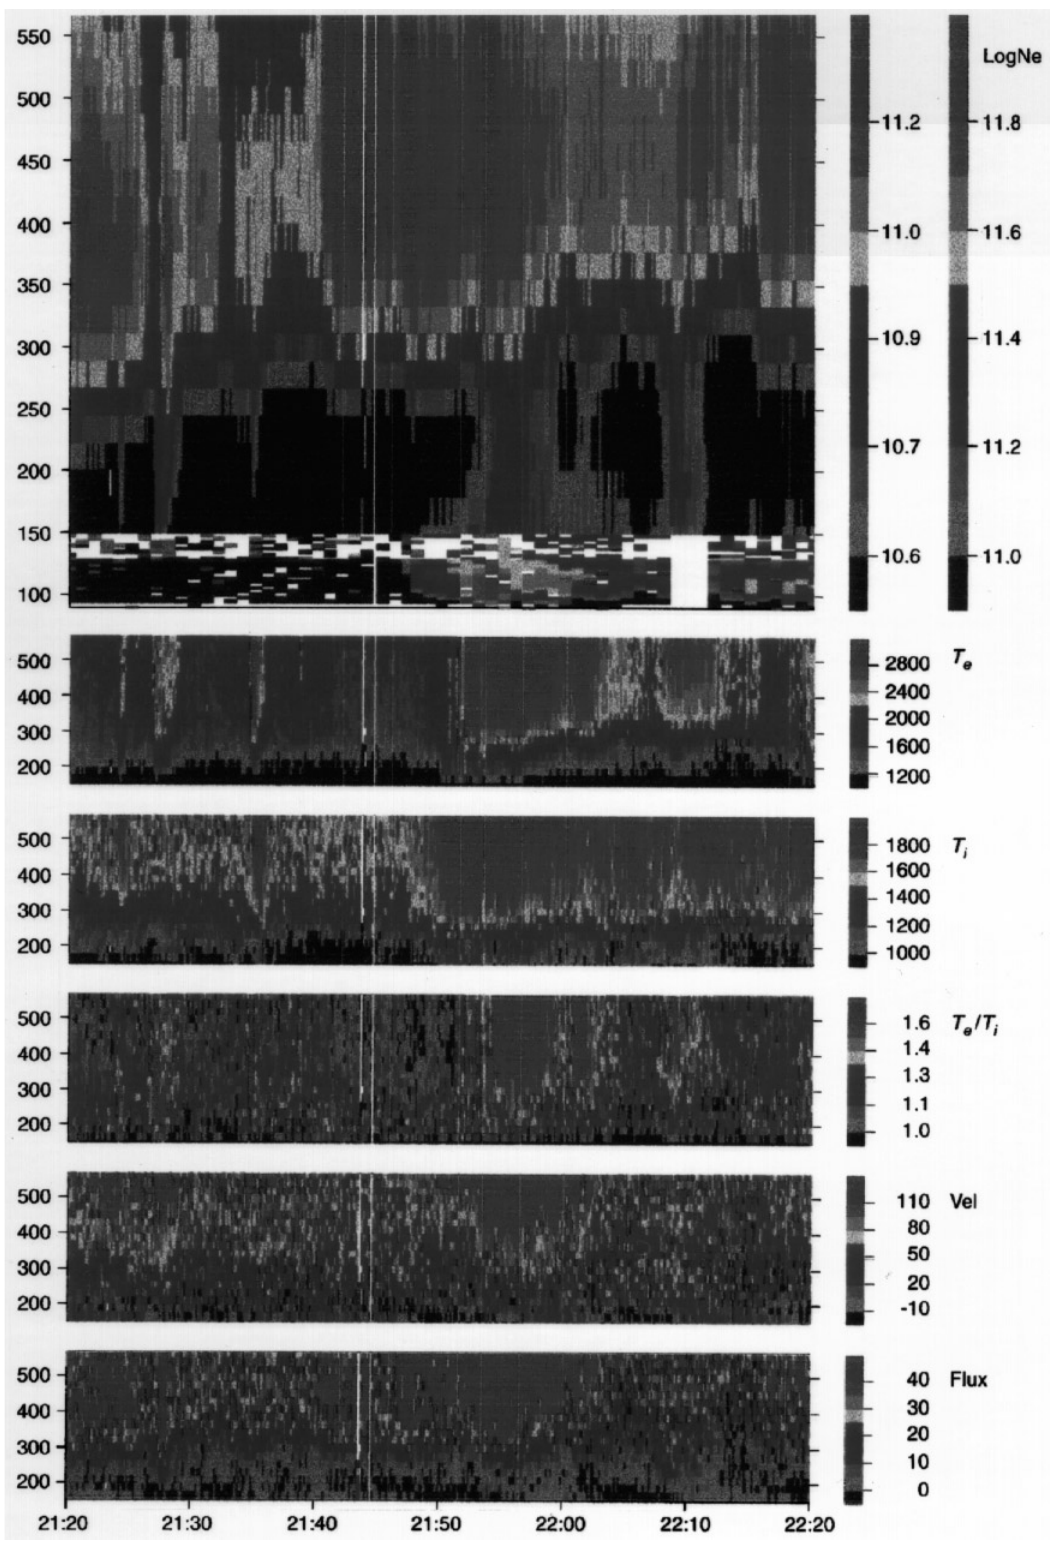
ature, „ (cid:105) (K), the temperature ratio „ (cid:101) / „ (cid:105) , the field-aligned ion bulk flow velocity (ms (cid:126)(cid:49) ) and the field-aligned ion flux (in units of 10 (cid:49)(cid:50) m (cid:126)(cid:50) s (cid:126)(cid:49) ). The data in the narrow panels comes from the long pulse data alone (150 — 570km) while panel (cid:49) includes multipulse data (90 — 150km). The left-hand colour key in panel 1 applies to the multipulse data and the right-hand colour key to the long